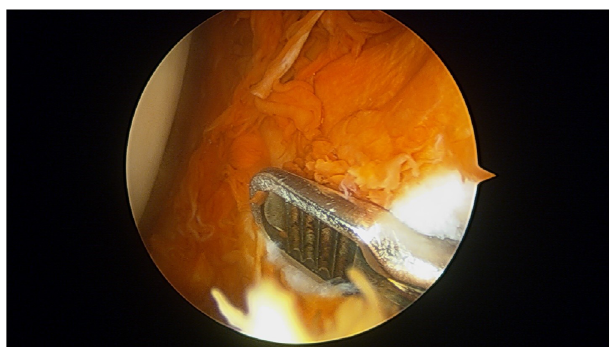
Figure 1. Intraoperative arthroscopic image showing punch biopsy being taken in a case of pigmented vilo-nodular synovitis.